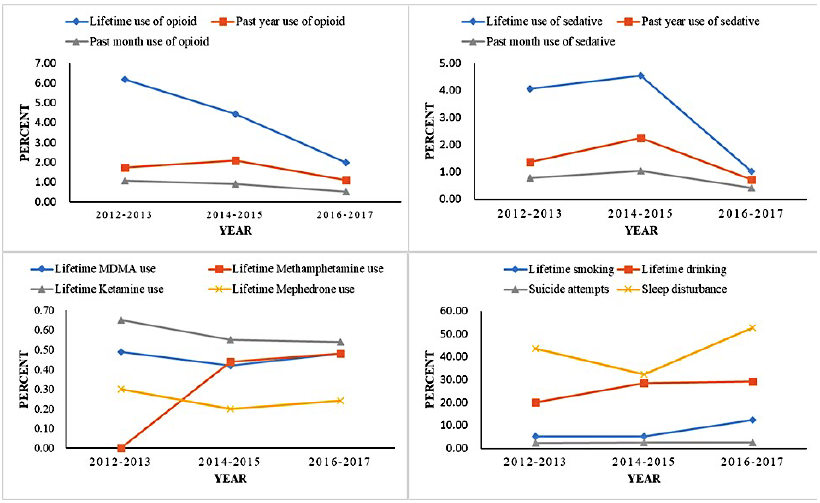
Figure 1. Trends in health-risk behaviors among Chinese adolescents in Guangdong Province.